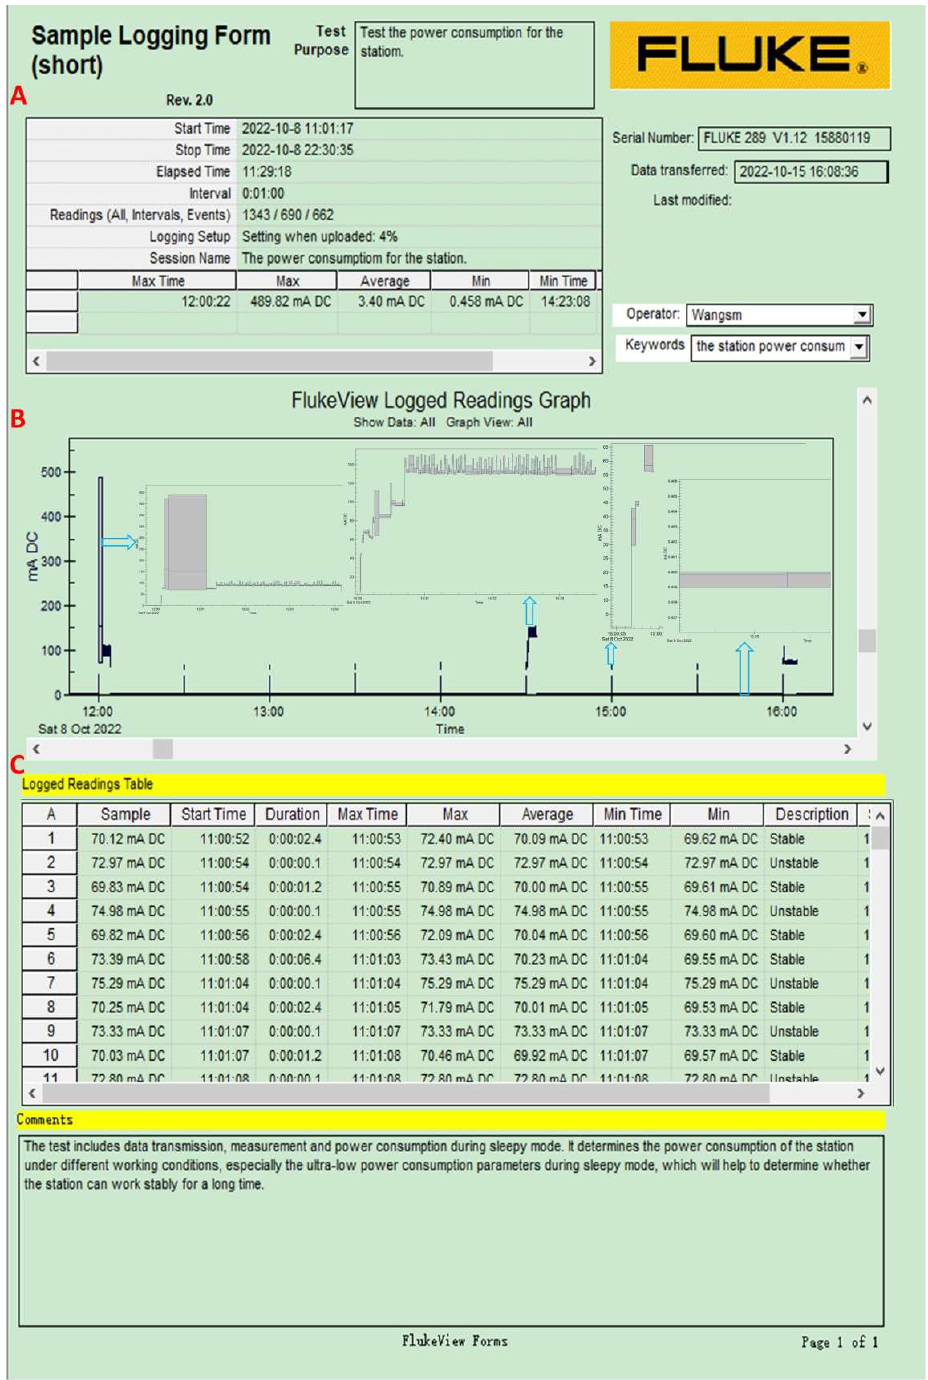
Figure 7. Power consumption measurement for the glacier surface base station, including the logging descriptions ( A , upper panel), FlukeView GRAPH ( B , middle panel), and the detailed data ( C , bottom panel). The black long bar on the left refers to the power consumption when the station is receiving data from the corresponding unit and uploading the data to the cloud data platform at a set time (12:00 a.m. in the figure). The black short thin bar refers to the surface station’s (itself) power consumption when measuring and uploading the data to the cloud data platform at a set time (14:30 p.m.). The black discontinuous lines refer to power consumption when measuring data. The horizontal line between the two black short thin bars is the power consumption of the station in the sleep mode. The details are shown in the inner corresponding panel.